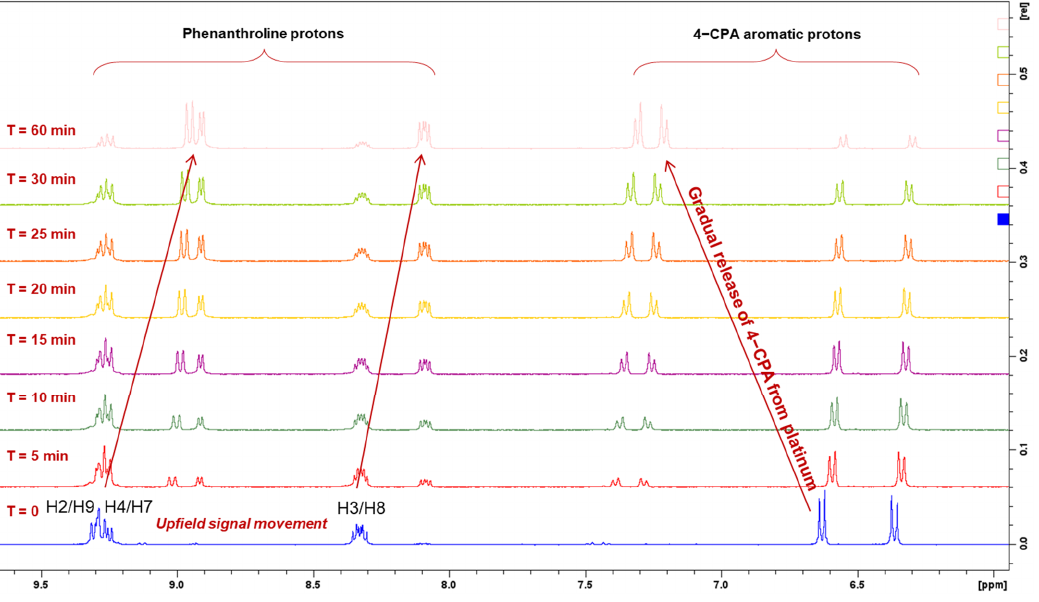
Figure 17. Zoomed 1 H − NMR spectra of 2 with PBS and AsA in D 2 O at 37 °C, in different time intervals, highlighting the movement of resonances from the phen protons and the aromatic protons of the 4 − CPA ligand. T represents time in min.